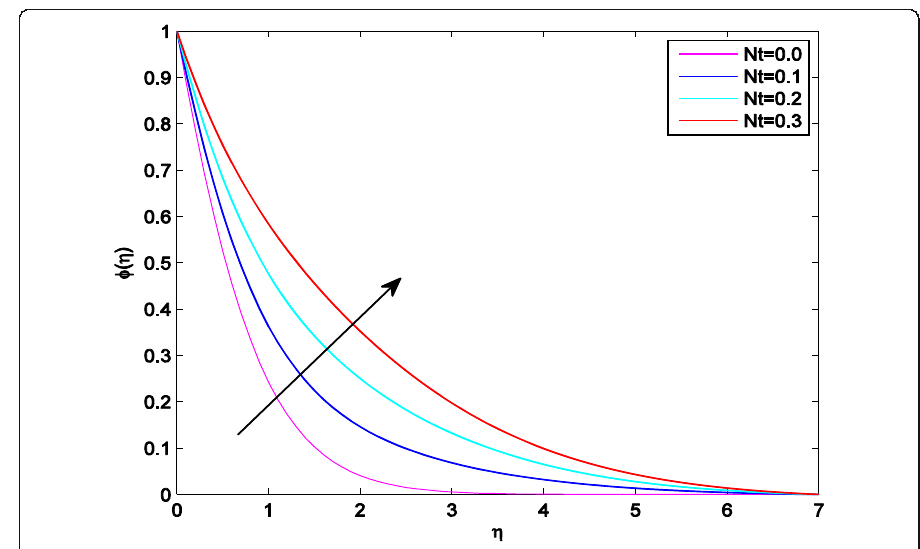
Fig. 15 Concentration graph for various values of Nt